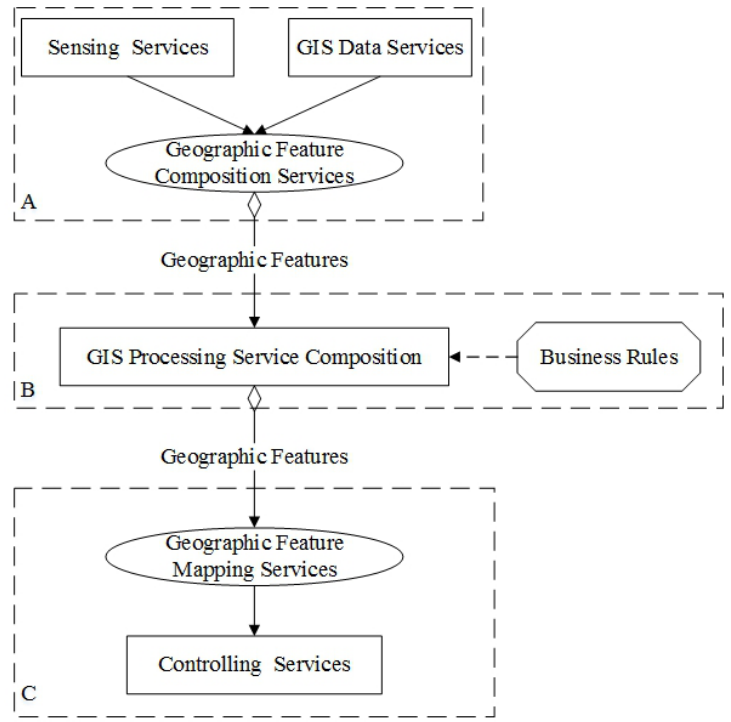
Figure 5. Tasks of GIS-oriented IoT service application